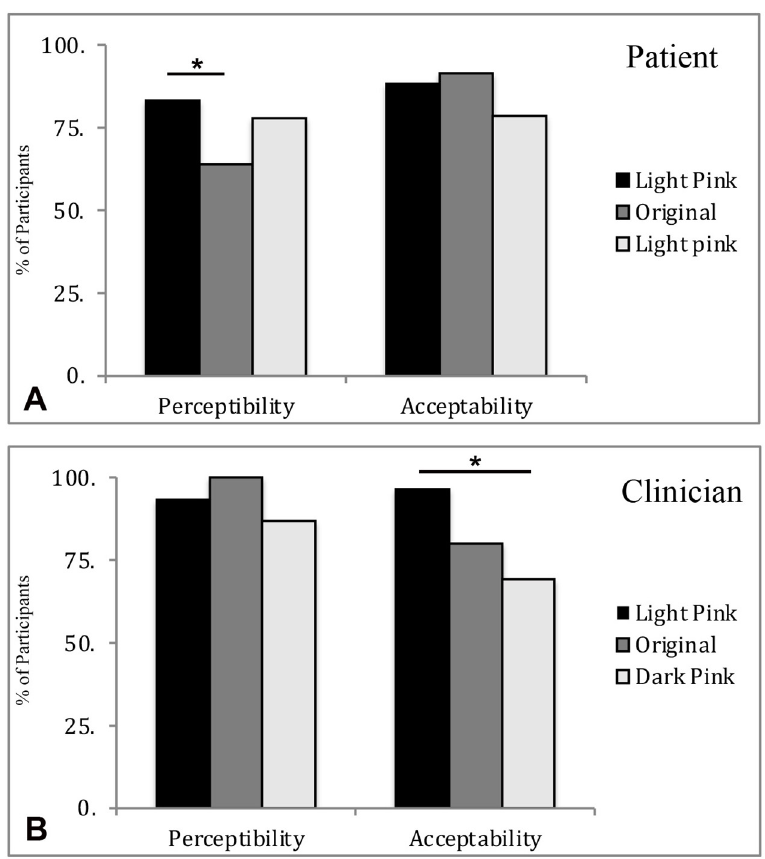
Figure 5. Percentage of survey participants that perceived and accepted color difference between non-coated and coated PMMA: ( A ) Patients ( B ) Clinicians. * denotes significant difference between the groups.